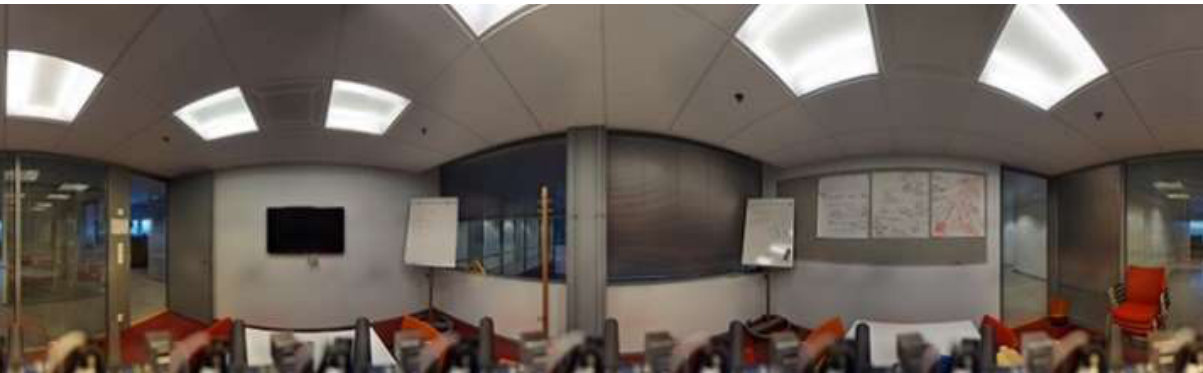
Figure 13. Panoramic image acquired with the motorized mount after the mount